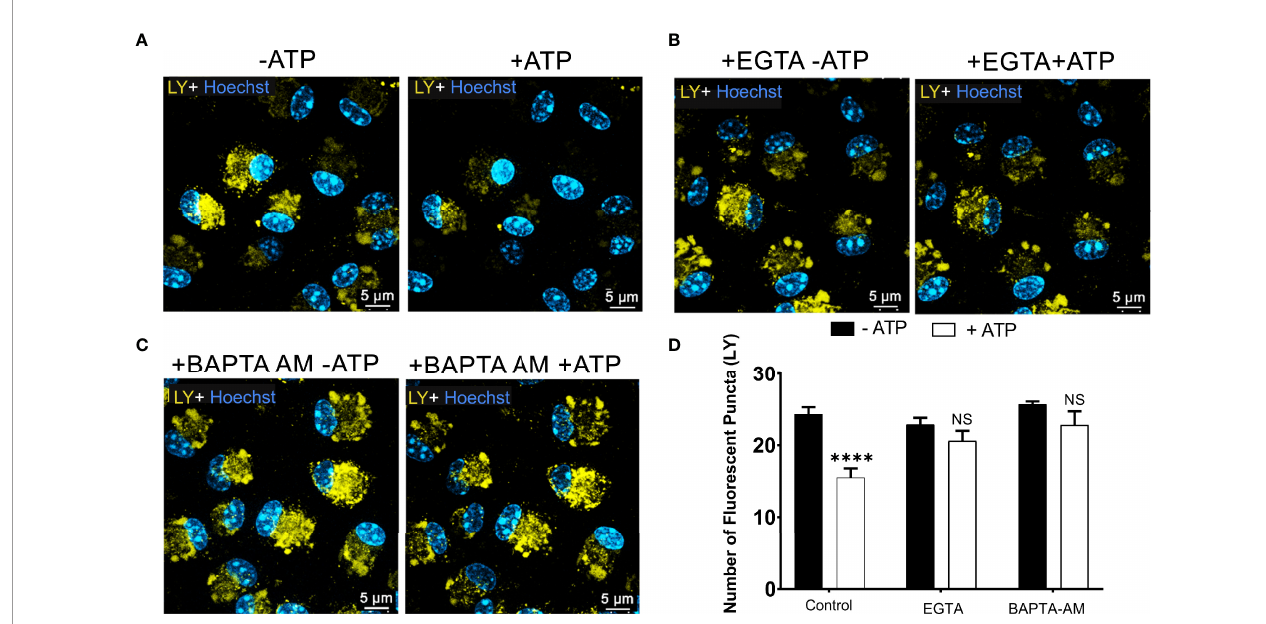
FIGURE 4 | P2X7 Receptor-Induced Lysosomal Rupture depends on Calcium Mobilization. Representative images of peritoneal macrophages labeled with 1 mM of Lucifer Yellow (LY) for 45 min, (A) without calcium chelators, (B) with 2mM EGTA, and (C) 10µM BAPTA-AM chelators, and then treated or not with 5 mM ATP for 10 minutes. (D) The number of lysosomes stained with LY was counted before and after treatments. Data are expressed as mean ± SEM of three independent experiments performed in triplicates and analyzed using one-way analysis of variance ****P < 0.0001. Analysis of conditions without ATP vs. after treatment with 5 mM ATP. NS, not signi fi